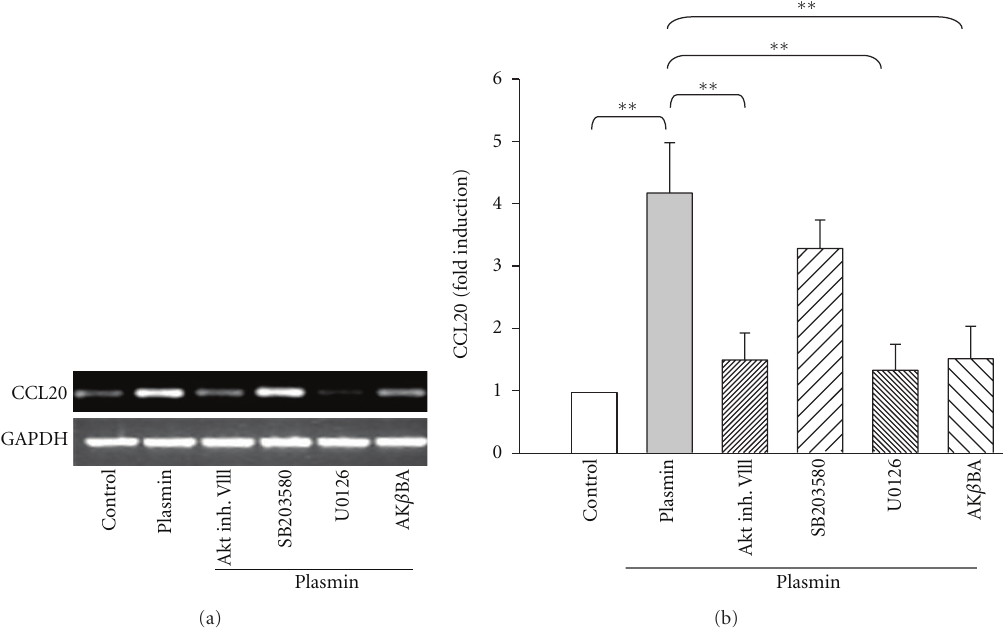
Figure 5: Activation of Akt and ERK1/2 is indispensable for the plasmin-induced CCL20 expression. (a) RT-PCR analysis of CCL20 mRNA expression. Dendritic cells were pretreated with the Akt inhibitor VIII, the MEK inhibitor U0126, the p38 inhibitor SB203580 (each at 1 μ M), or the I κ B kinase inhibitor AK β BA (10 μ M) for 15 min and then stimulated with plasmin (0.143CTAU/mL) for 6h. mRNA was isolated and subjected to RT-PCR using CCL20-specific primers; GAPDH served as control. Representative data of 3 independent experiments are shown. (b) Release of CCL20 by plasmin-stimulated dendritic cells. Dendritic cells were treated as in A, but for 24 h, and CCL20 release into the